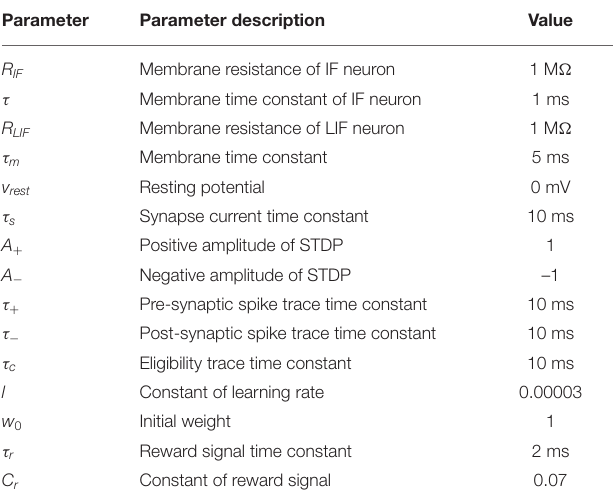
TABLE 1 | The parameters used in Spiking Neural Network (SNN) models and learning